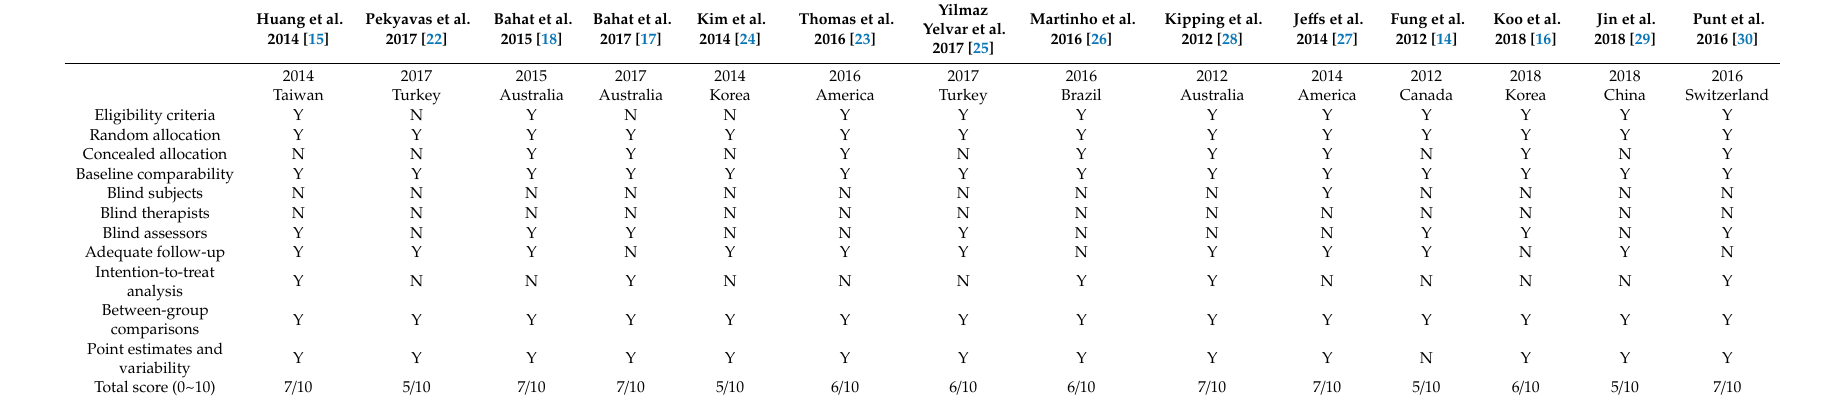
Table 1. Physiotherapy Evidence Database (PEDro) Score for Included Studies ( n =